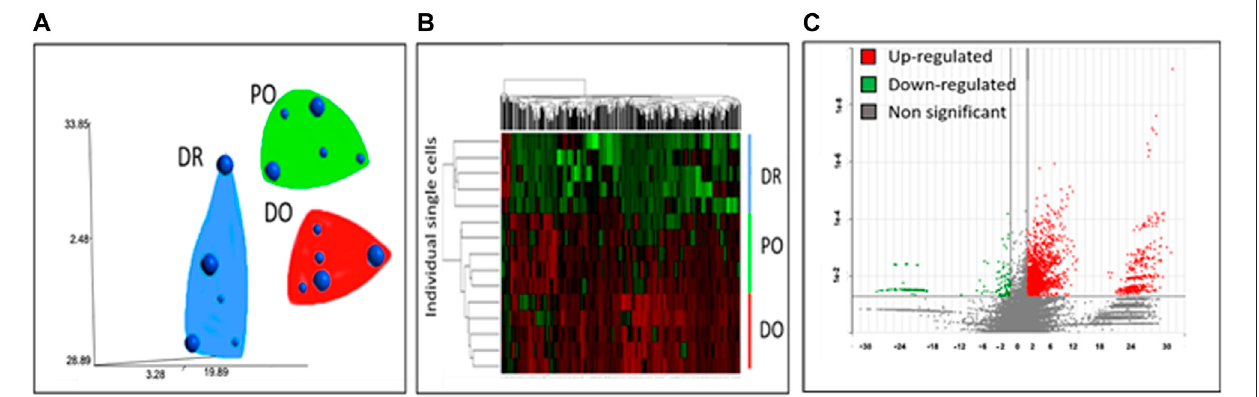
FIGURE 2 | Clustering of differentiating single MSCs. Single-cell transcriptome analyses of gene expression pro fi les group cells into 3 clusters: differentiated osteoblasts (DO), differentiation-resistant MSCs (DR-MSCs), and precursor osteoblasts (PO). (A) 2 Dimensional representation of T-distribution stochastic neighbor embedding (tSNE) of gene expression pro fi les associated with single-cell transcriptomes. Small spheres represent cells harvested on day 12. In contrast, large spheres represent single cells harvested on day 19. Groups were determined based on gene expression similarity (B) The genes represented in the hierarchical clustering were signi fi cantly different among the three groups. ( p < 0.05 and > 2fold change); hierarchical clustering clearly identi fi es three groups with separate gene expression pro fi les (C) Genes differentially expressed ( p < 0.05, fold difference > 2) between the differentiation resistant group (DR-MSCs) and the differentiated osteoblasts (DO). Y -axis representslog-transformed p -values, while X -axis shows fold change between groups. There were 3,126 genesupregulated in DO (red) and 117downregulated in DO (green). Genes that were not signi fi cantly differentially expressed between the two groups are grey (Refer to Supplementary Tables S1 – S3